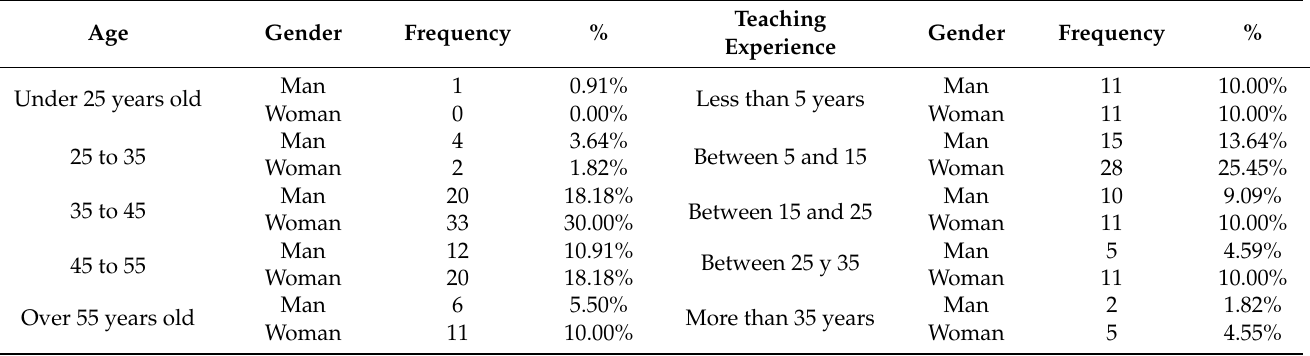
Table 1. Age, gender, and teaching experience of the study participants.